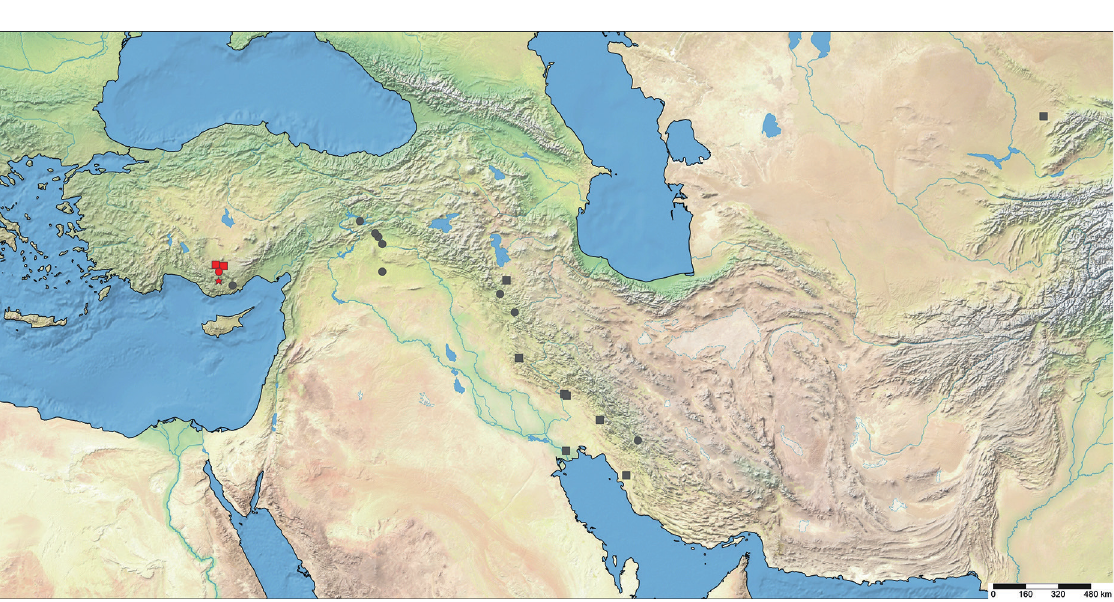
Fig. 5. Distribution of Plagiognathus spp. Star: P. ozgurkocaki sp. nov.; circle: P. marivanensis Linnavuori, 2010; square: P. bipunctatus albicans (Reuter, 1901). Grey color indicates previous literature records, red color indicates new records presented in this